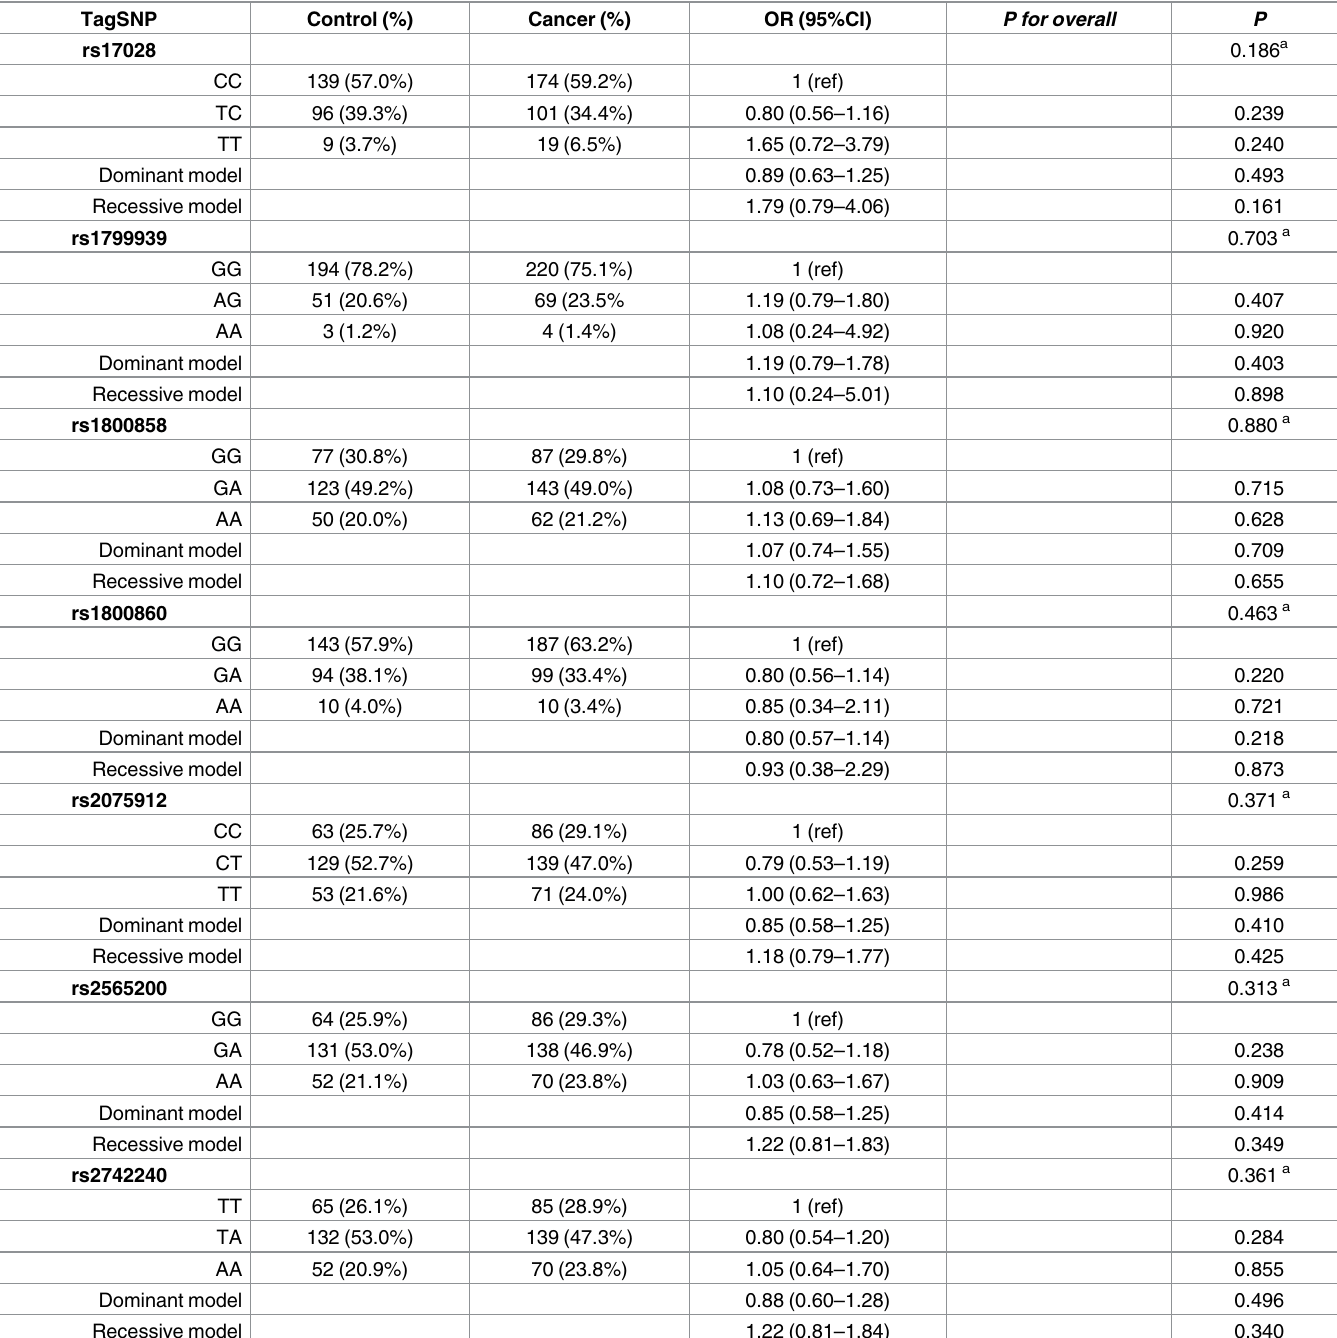
Table 2. Association between RET tagSNP and susceptibility to thyroid